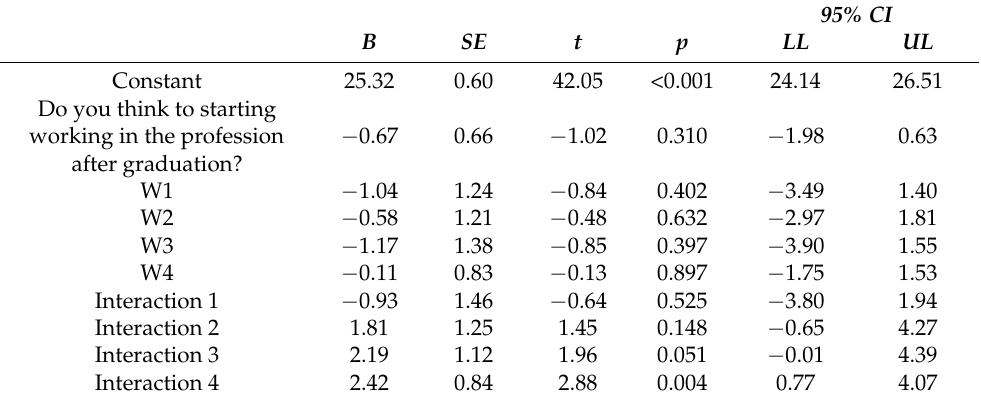
Table 4. Regression coefficients for the model considering the moderating role of the place of residence for the relationship between the decision to go to work after graduation from nursing and